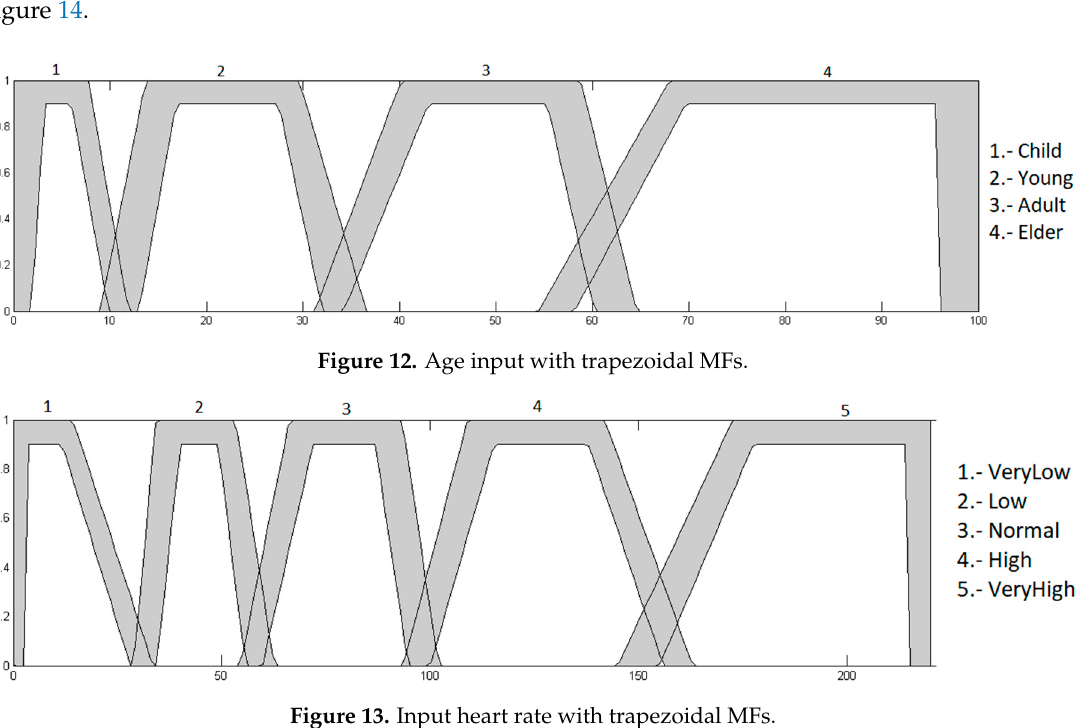
Figure 13. Input heart rate with trapezoidal MFs.